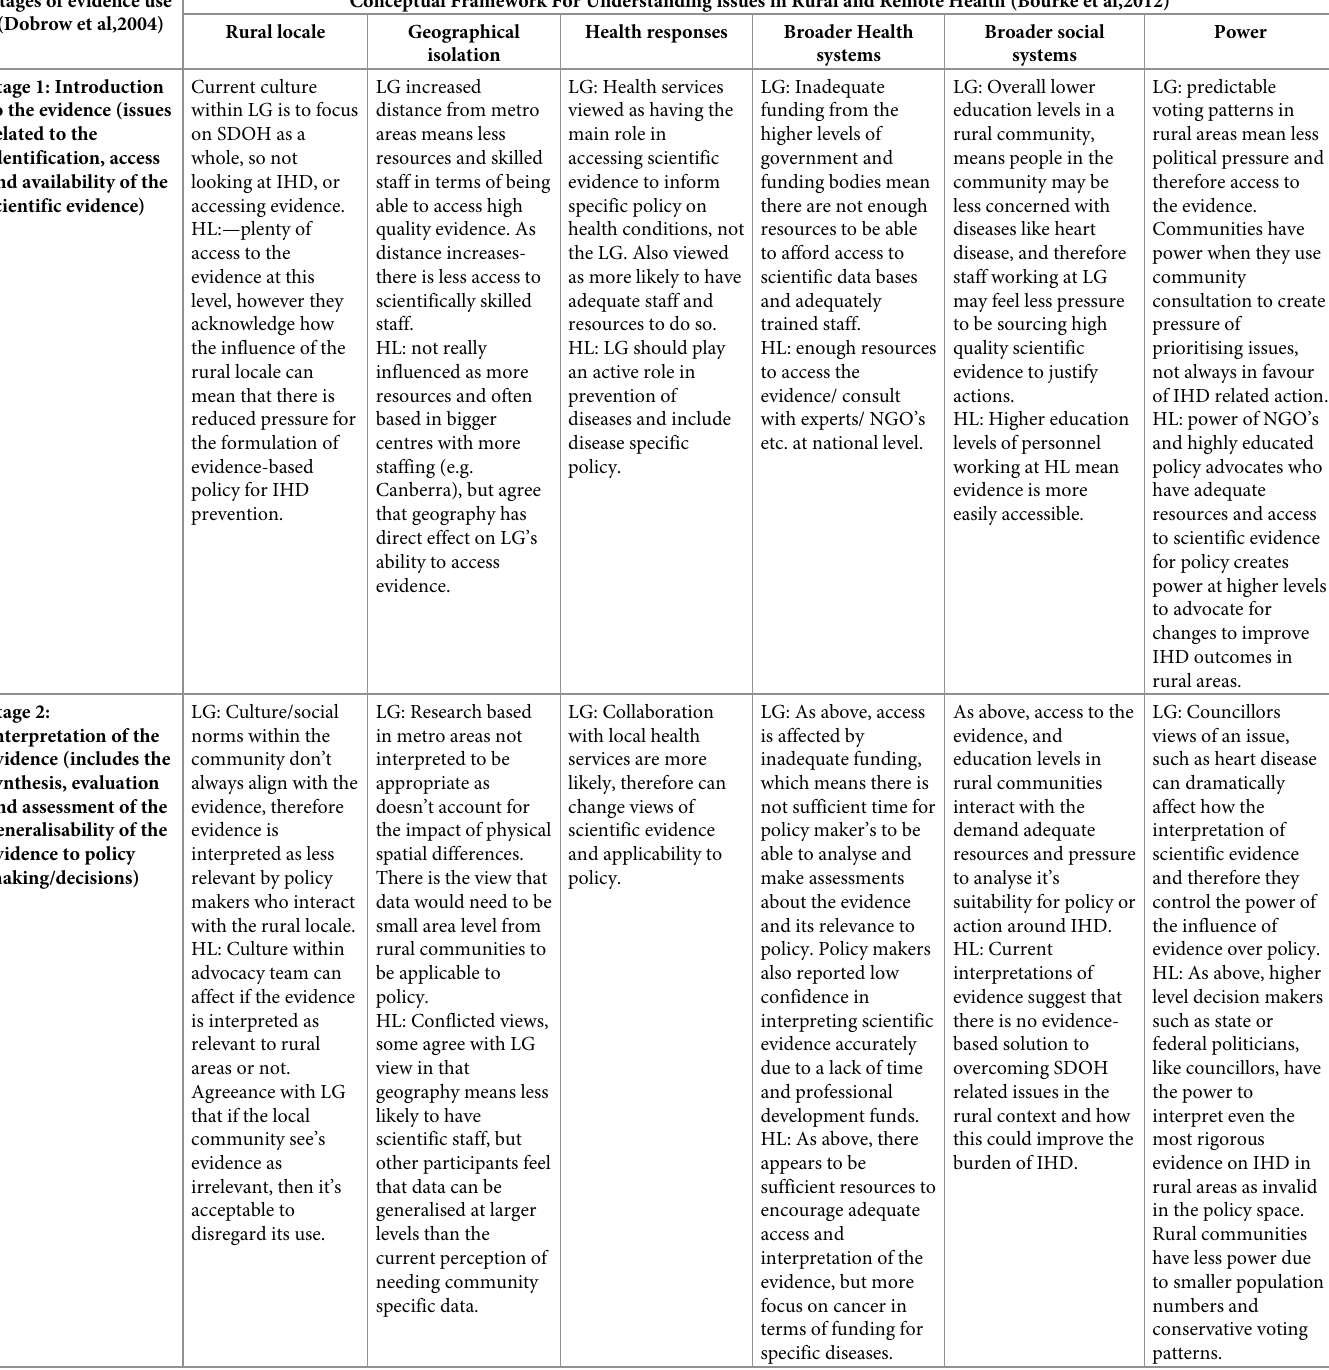
Table 4. Summary of the theoretical thematic analysis to show the influence of the Australian rural context on the use of the evidence in the policy making process for the prevention of IHD. Stages of evidence use (Dobrow et